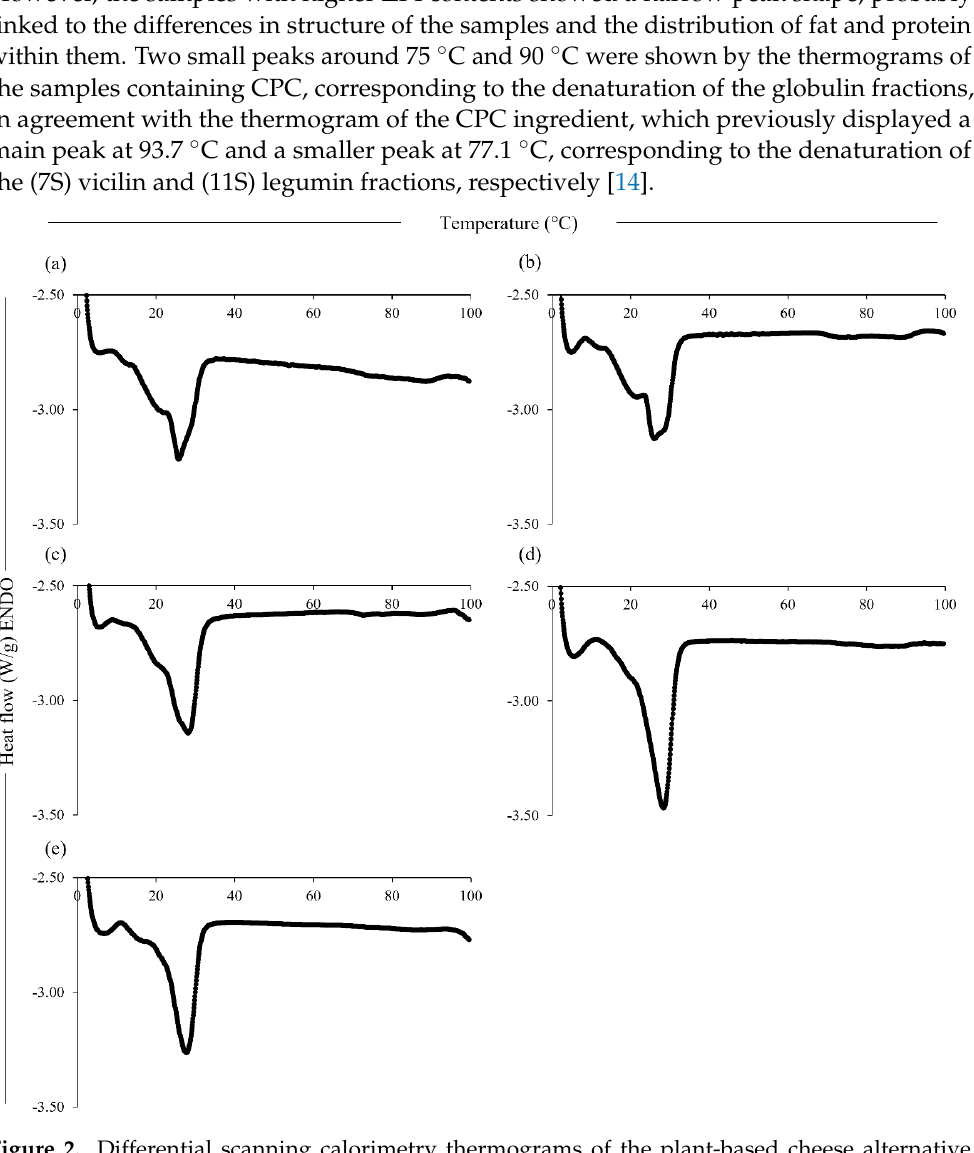
Figure 2. Differential scanning calorimetry thermograms of the plant-based cheese alternative samples, 0Z-100C ( a ), 25Z-75C ( b ), 50Z-50C ( c ), 75Z-25C ( d ) and 100Z-0C ( e ).